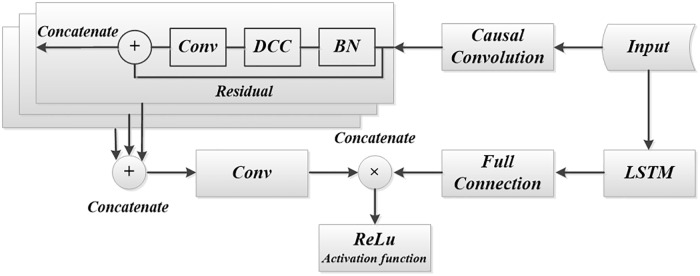
Deep learning network model based on DCC.